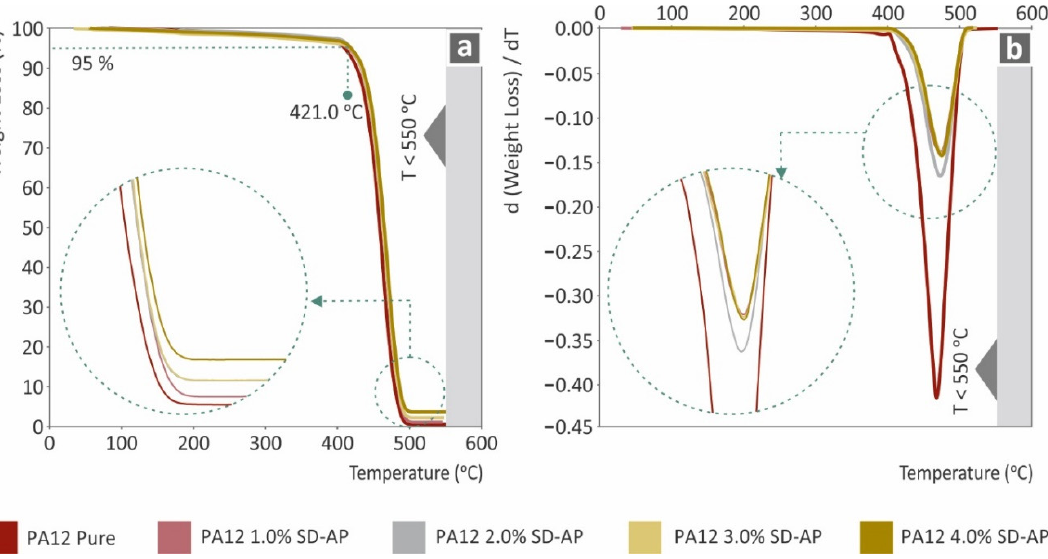
Figure 12. ( a ) Sample weight (%) to temperature ( ◦ C) for all tested nanocomposites and neat PA12; ( b ) DTGA curves of weight loss rate to temperature ( ◦